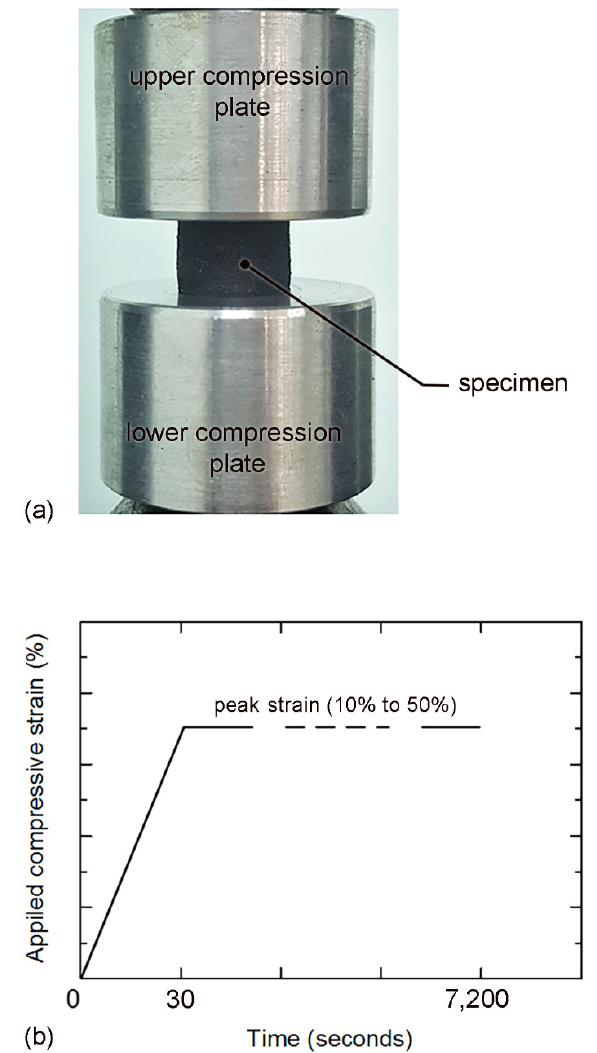
Figure 4. ( a ) Compressive stress relaxation test; and ( b ) applied compressive strain vs. time.